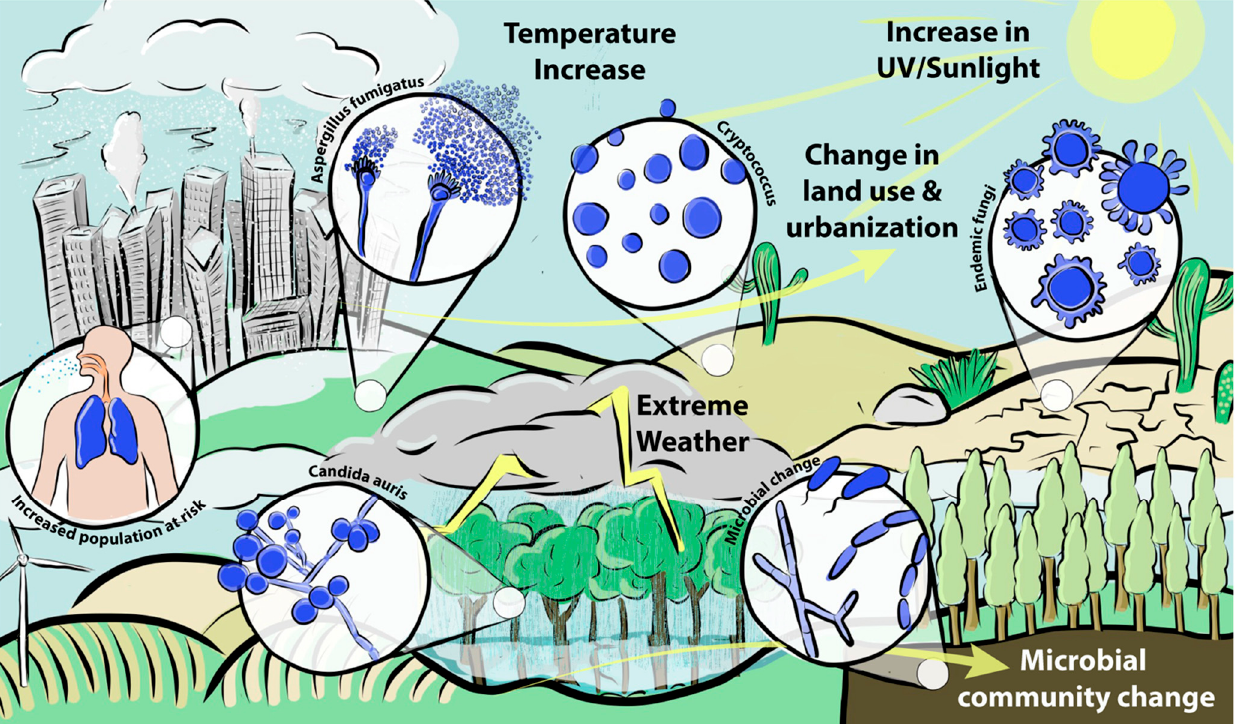
Figure 1. Schematic overview of changes in the epidemiological landscape of fungal pathogens and associated changes in environmental parameters.